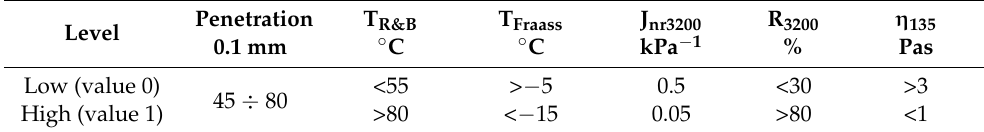
Table 7. Utility profile ranges adopted for optimisation